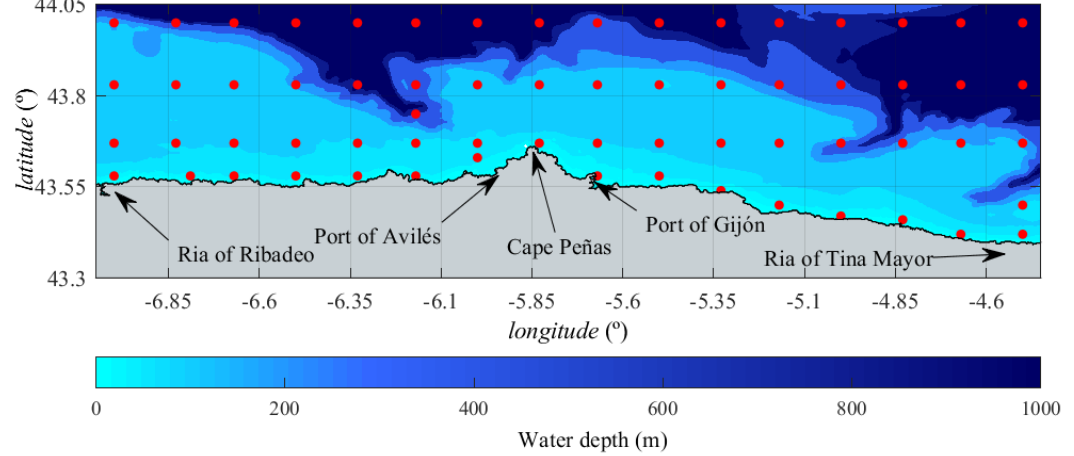
Figure 1. Bathymetry of Asturias and location of the SIMAR data points considered in this work. The water depths are in meters